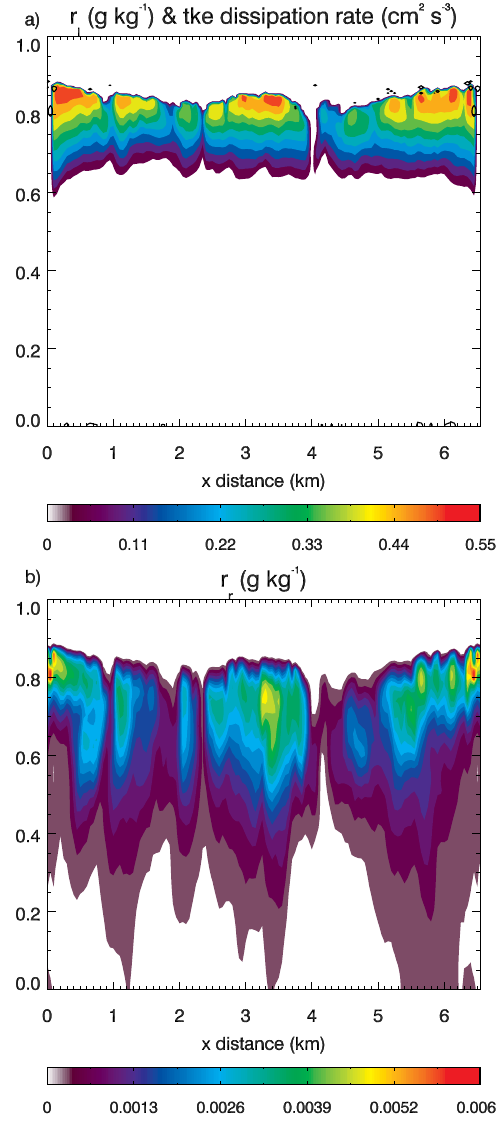
Figure 2. Cross sections of the (a) liquid and (b) rain water mix- ing ratios (gkg − 1 ) for the DYCOMS II case. Contour lines of the turbulent kinetic energy dissipation rate in (a) are 100cm 2 s − 3